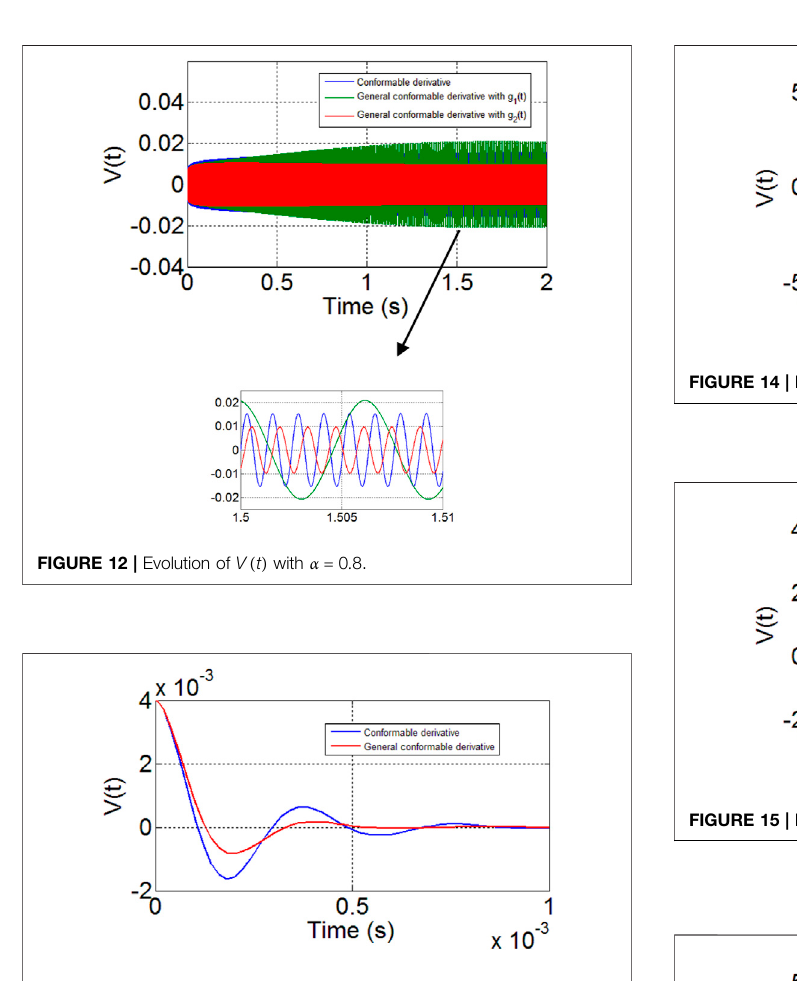
FIGURE 13 | Evolution of V ( t ) with α (cid:2) 0 . 98.